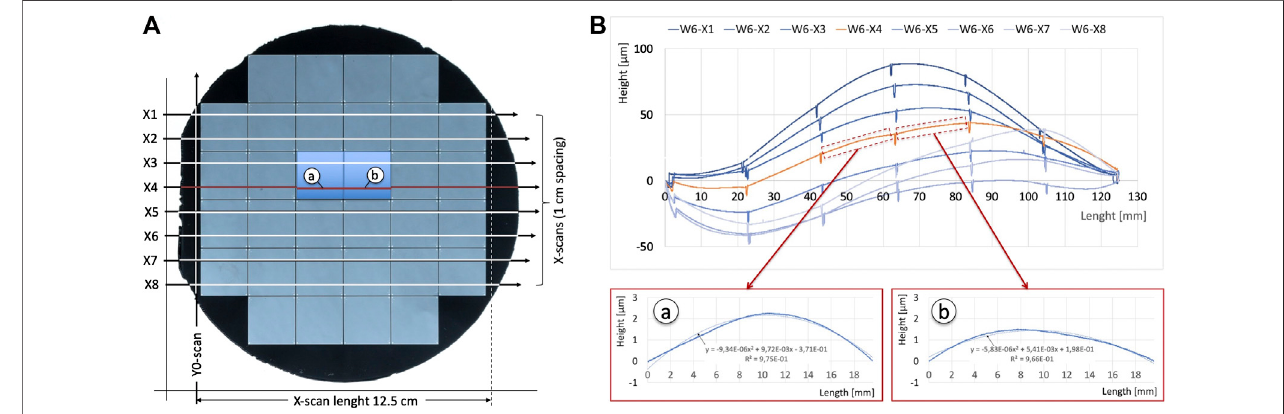
FIGURE 5 | Eight 12.5 cm long pro fi les (X1-X8), distanced by 1 cm, were taken with a 20 µm step on WLP 6 along X direction (A) sketch of the wafer with the pro fi les highlighted (B) top, eight pro fi les after rotation; bottom, in red the X4 pro fi le used toextract information on the warpage of the chips. The pro fi les are rotated and shifted to bind the two ends to have ordinates equal to zero.